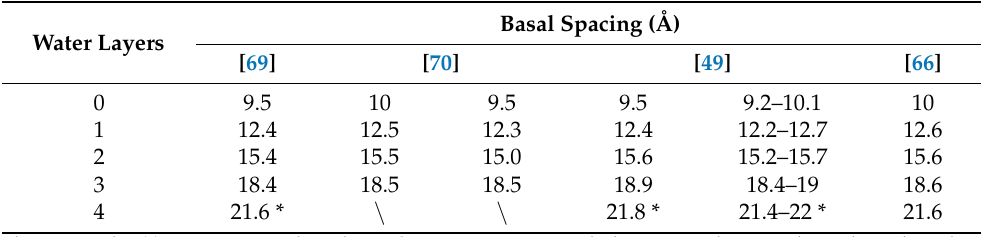
Table 1. The number of water layers between two adjacent TOT layers and basal spacing of compacted bentonite.